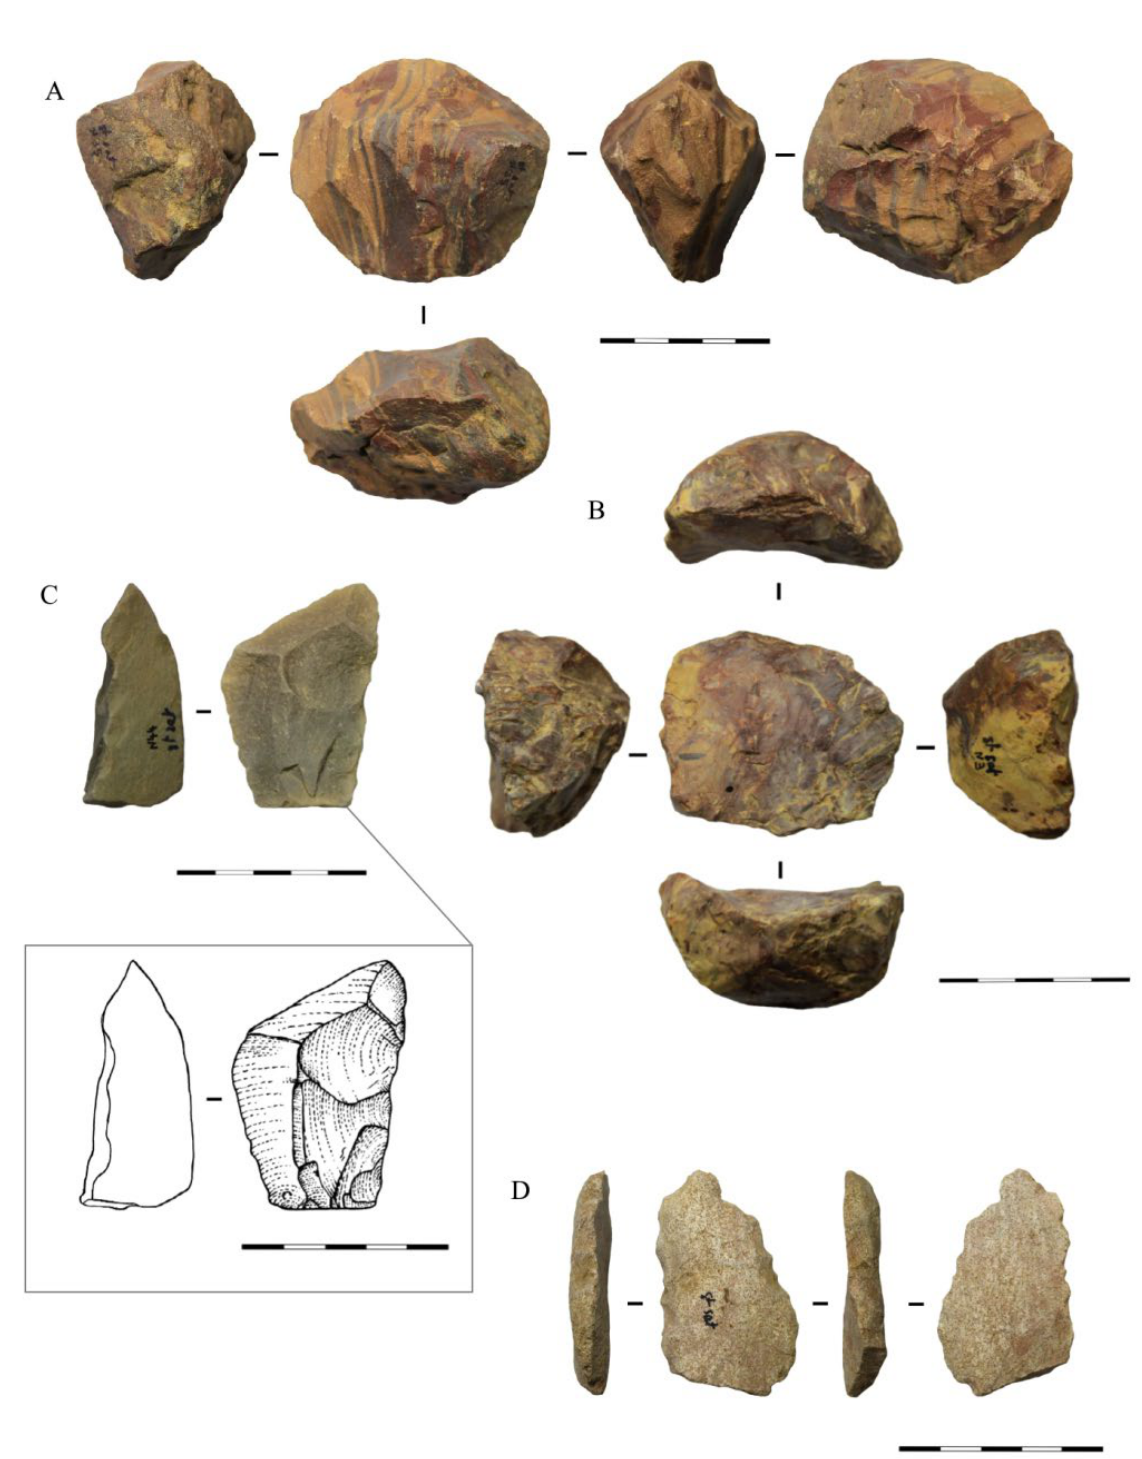
Figure 8. Lithic industry of Saint-Saturnin. A: Discoid core on jaspoid. B: typo-Levallois with preferential removal on quartzite. C: Recurrent Kombewa exploitation on a fine-grained quartzite. D: double denticulate on Jurassic flint. Scale bars: 5